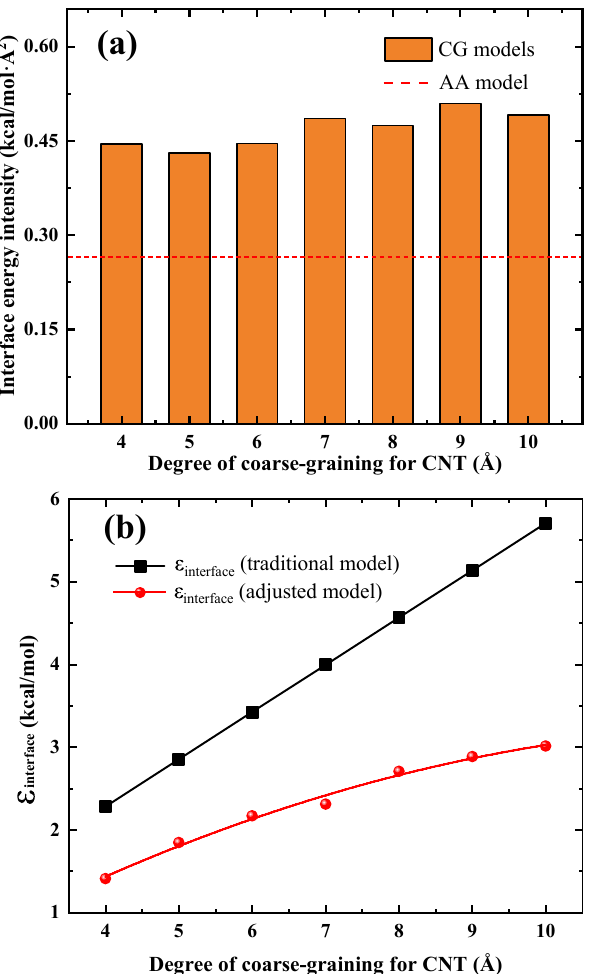
Figure 3. ( a ) Comparison of the interface cohesive energies between the AA and CG models, and ( b ) ε interface vs. λ curves for the traditional interface model (black line) and the adjusted interface mod el (red line) in this